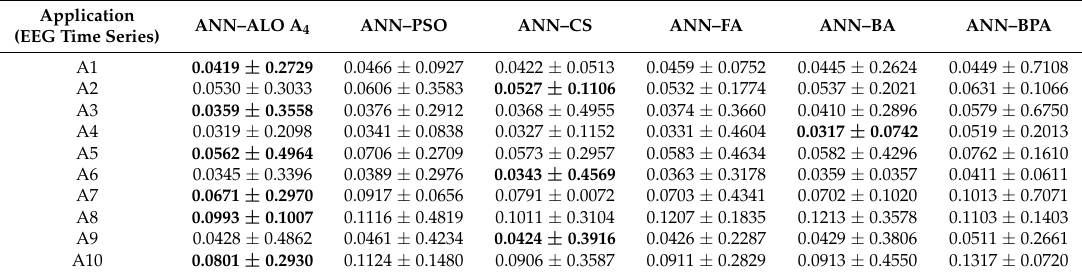
Table 8. Mean MSE and standard deviation of predictions done for the EEG time series via different ANN-based